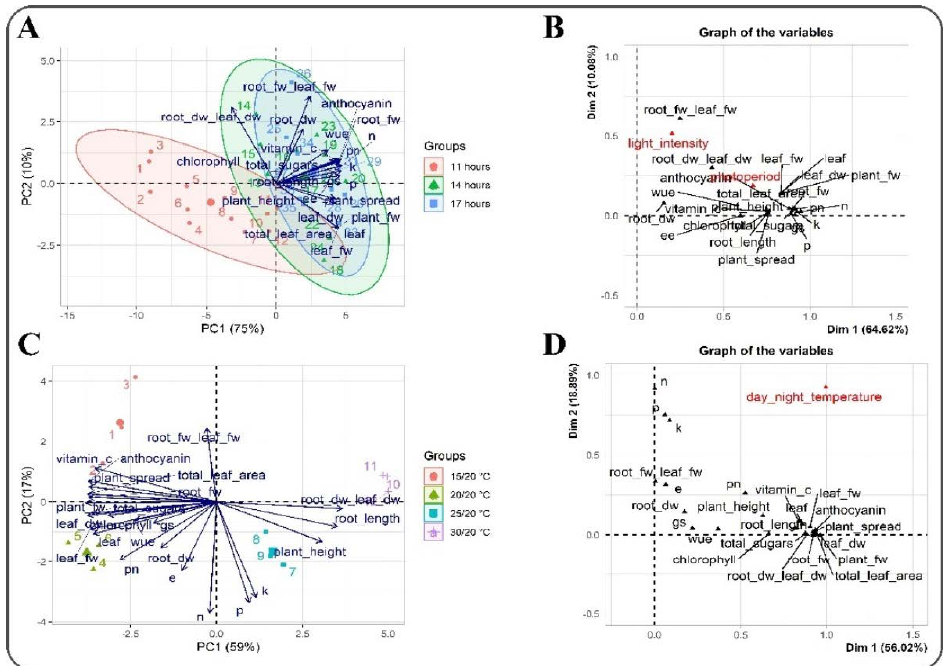
Figure 5. Biplot principal component analysis (PCA) and factor analysis of mixed data (FAMD) of the morphological, biochemical, and physiological attributes of lettuce plants. ( A ) PCA and ( B ) FAMD analysis under different photoperiod and light intensity regimes. ( C ) PCA and ( D ) FAMD analysis under different day/night temperature conditions. The distribution of attributes at different photoperiods and day/night temperatures is represented in different colors. The arrows and circles signify the levels and quantities of each